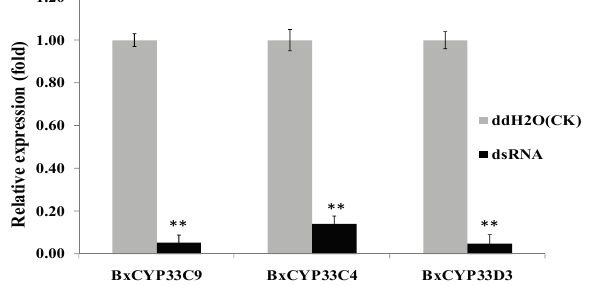
Figure 3. Quantitative real-time RT-PCR analysis of the RNAi efficiency in B. xylophilus after treatment with ds CYP33C9 , ds CYP33C4 and ds CYP33D3 . B. xylophilus soaked in ddH 2 O was used as control. Data represent mean values ± SD from three independent experiments. Bars show standard deviations of the mean. Asterisks on top of the bars indicate statistically significant differences (** p < 0.01, Student’s t -test) was found between the dsRNA-treated (ds CYP33C9 , ds CYP33C4 and ds CYP33D3 ) and control.